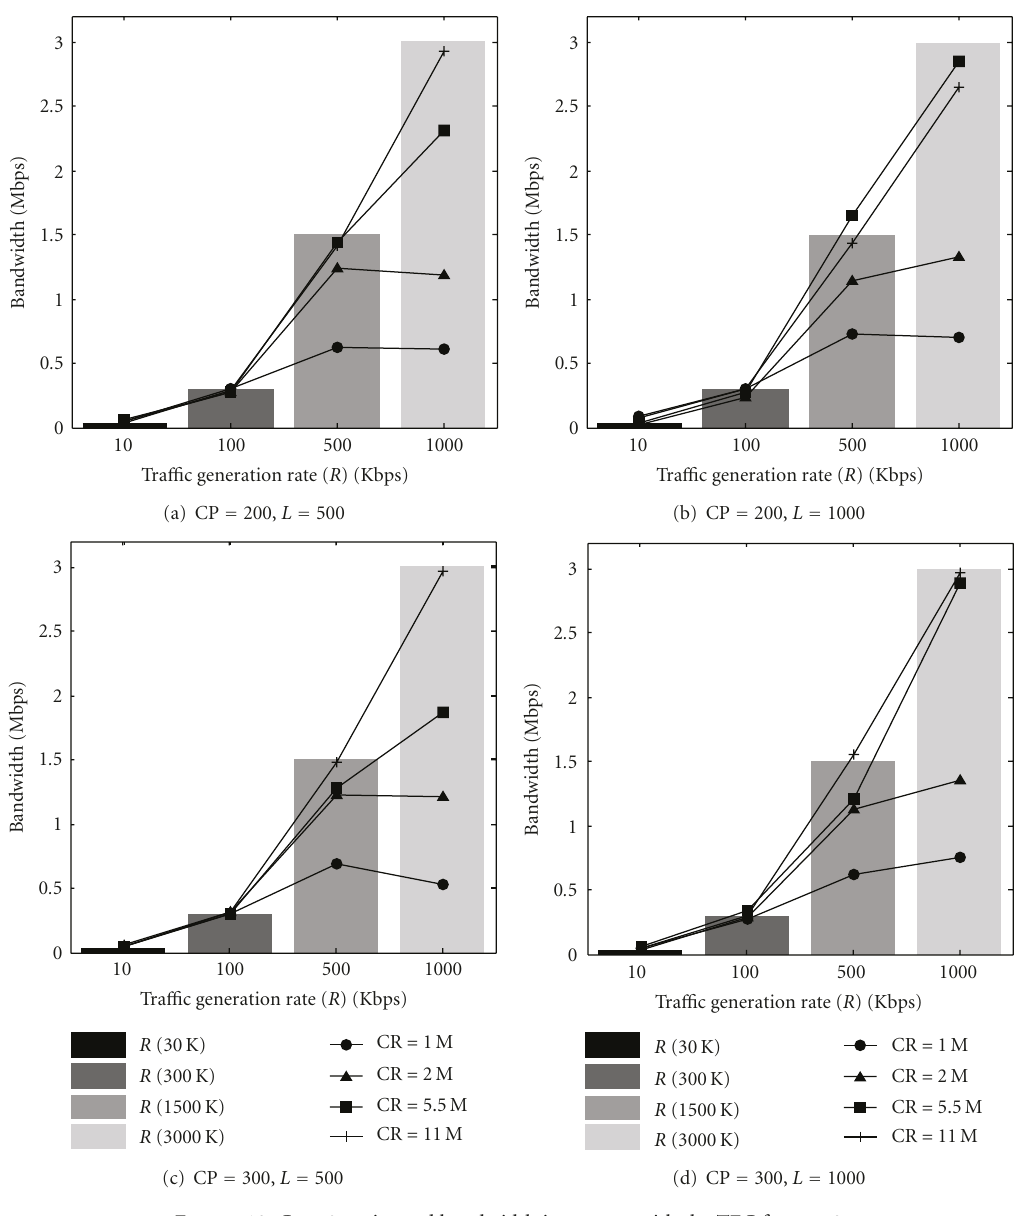
Figure 10: Case 2: estimated bandwidth in average with the TFC for n =